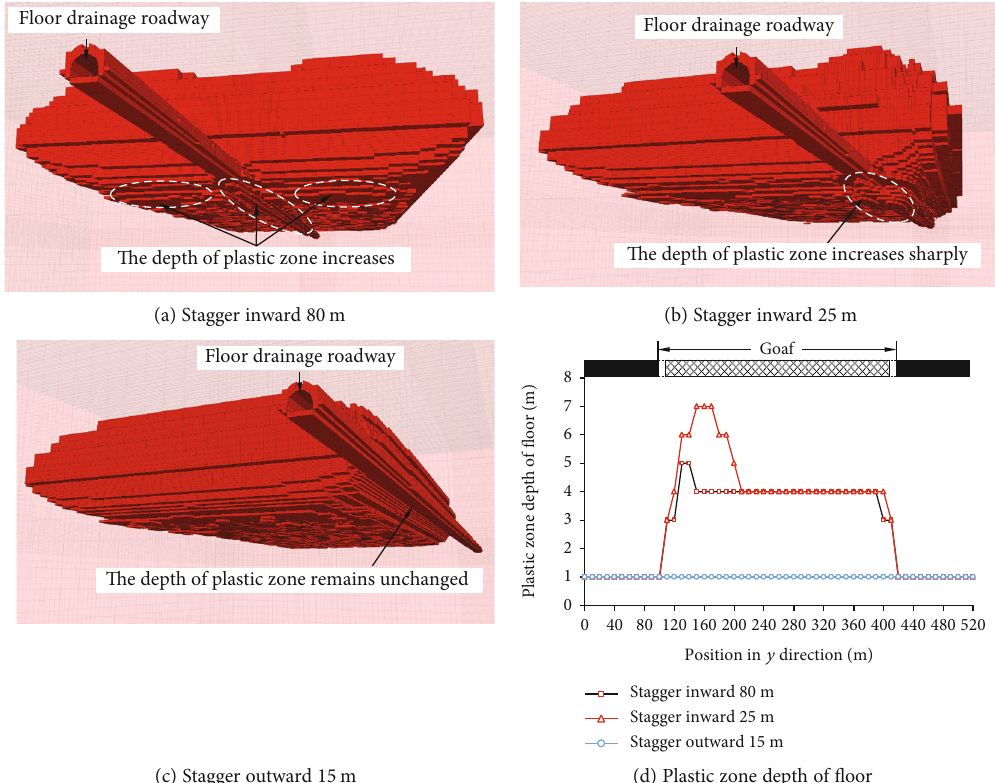
Figure 4: The plastic zone depth in fl oor extraction roadway a ff ected by single working